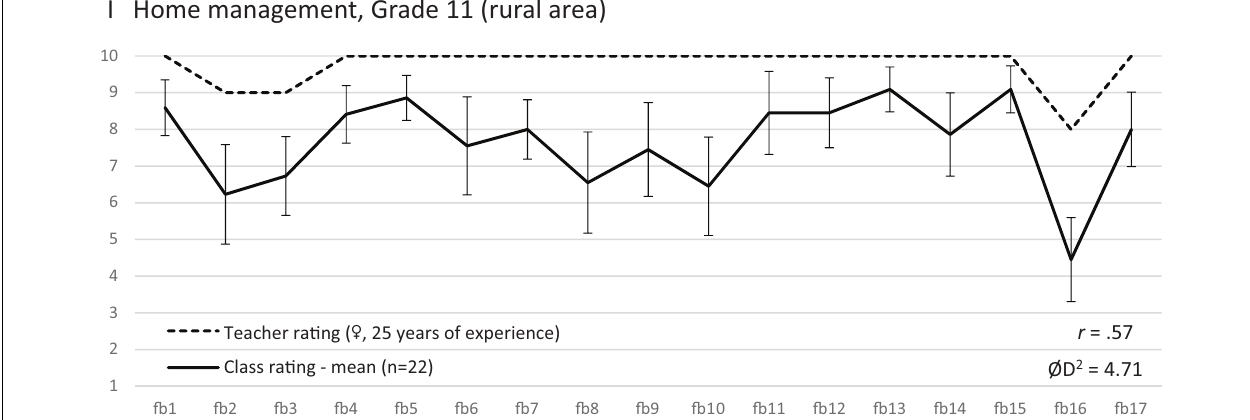
FIGURE 1 | Profile discrepancies (ØD 2 ) and correlations ( r ) between teacher and student ratings on all 15 items of the Fairness Barometer. Illustrated are prototypic profiles showing almost no differences (Class A , top image), specific discrepancies (Class C , middle image), and general perception differences (Class I , bottom image). Error bars indicate 95% CI. Interest in the subject (fb16) and perceived general fairness (fb17) were excluded from computation of ØD 2 and r .